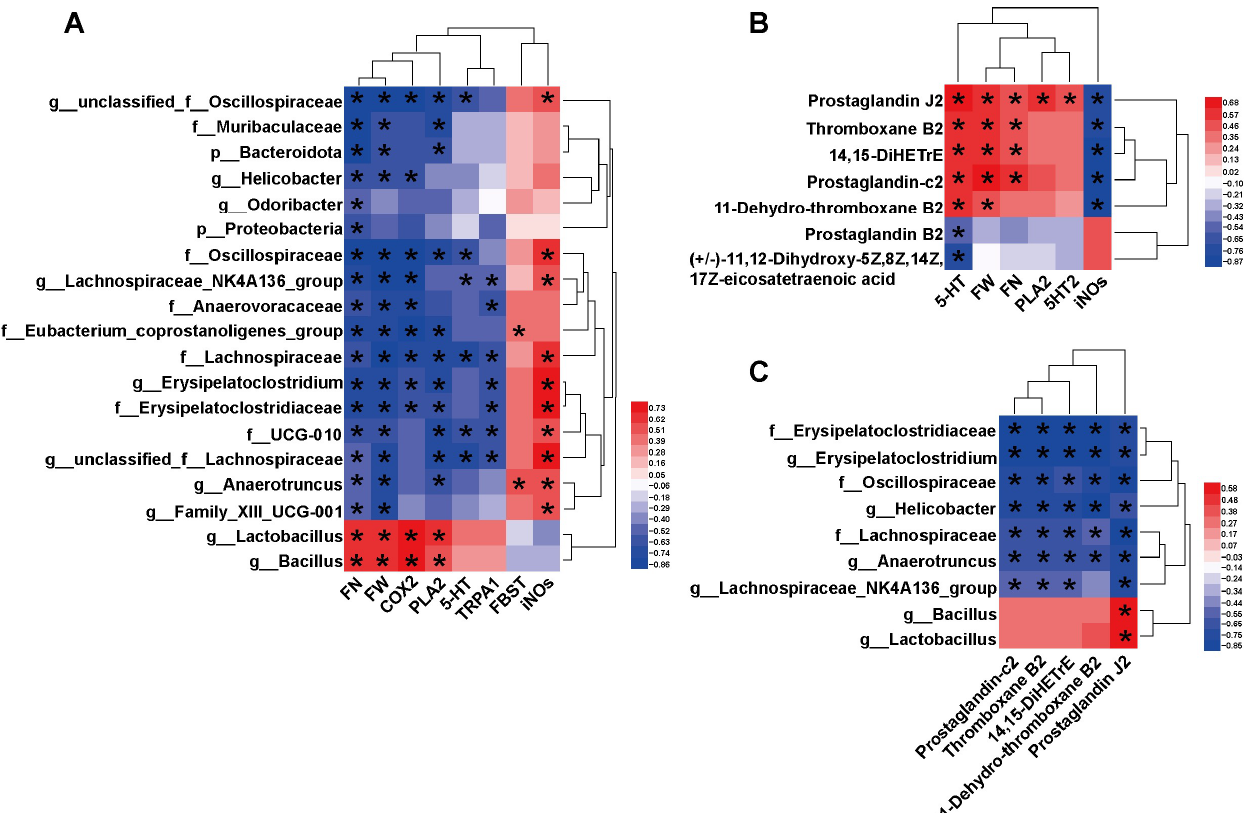
Figure 6. Heatmaps showing bivariate correlations between specific gut microbiota, gut metabolites and core host parameters in STC mice. ( A ) Correlations between the differential microbe taxa and differential host parameters. ( B ) Correlations between differential intestinal metabolites in serotonergic synapses and differential host parameters. ( C ) Correlations between the differential microbe taxa and differential intestinal metabolites in serotonergic synapses. The color at each intersection indicates the value of the r coefficient; p values were adjusted for multiple testing according to the BH procedures. * indicates a significant correlation between these two parameters ( p < 0.05, n = 6 in each group).